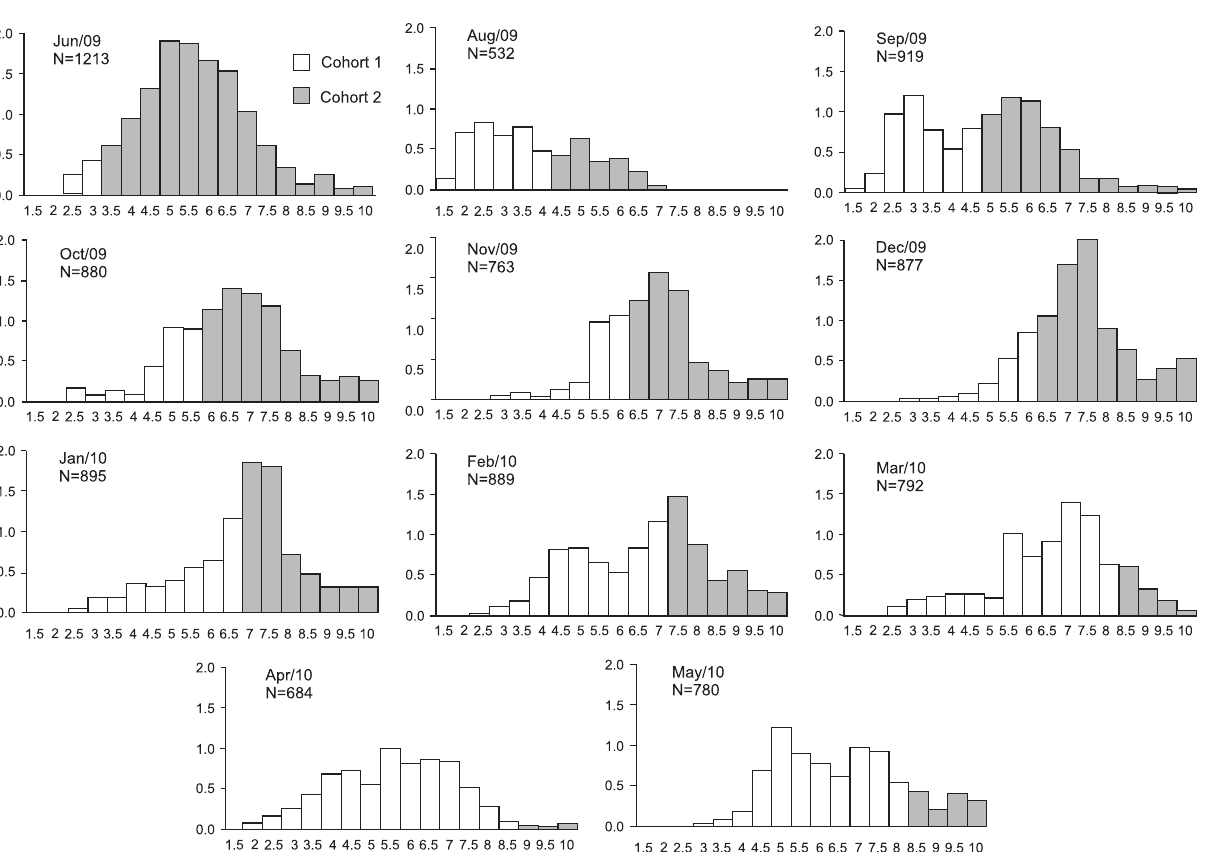
Figure 6. Frequency histograms of size classes of L3S (mm) of Scolelepis goodbodyi between June/09 and May/10, showing two distinct cohorts.